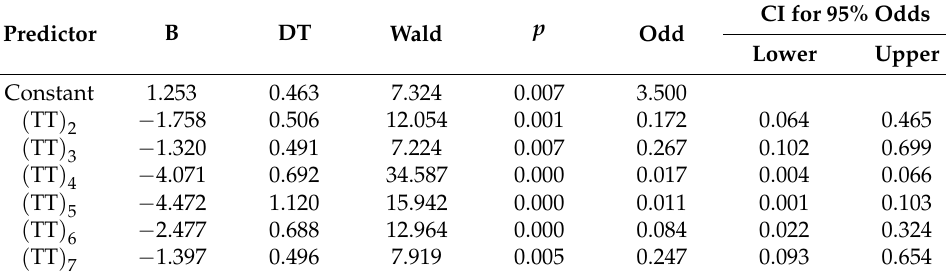
Table 3. Logit model for survival (therapeutic